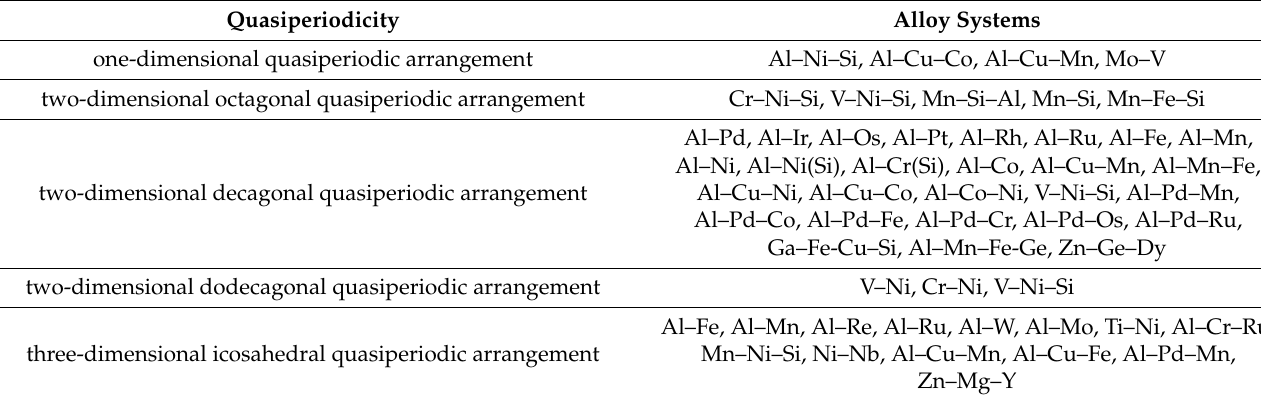
Figure 1. Chemical elements forming thermodynamically stable QCs. Main forming elements (Al, Ti, Zn, Cd) are marked by orange color, alloying elements are denoted by green. Table 1. Examples of quasicrystalline phases, compiled from references [7,8,10–23].